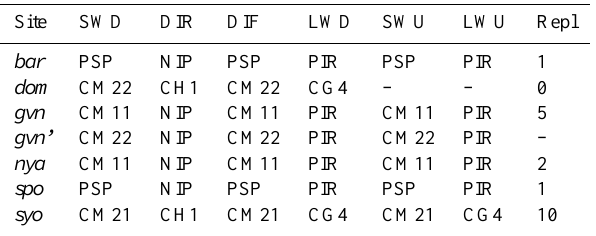
Table 2. Set of instruments adopted by various stations for the various components. The “Repl” column indicates how many times a set of the same type was completely or partially replaced. gvn replaced CM11 with CM22 on February 2009. spo replaced just pyrgeometer. syo replaced pyrheliometer many times along the IPY period. Details are given in the metadata of the